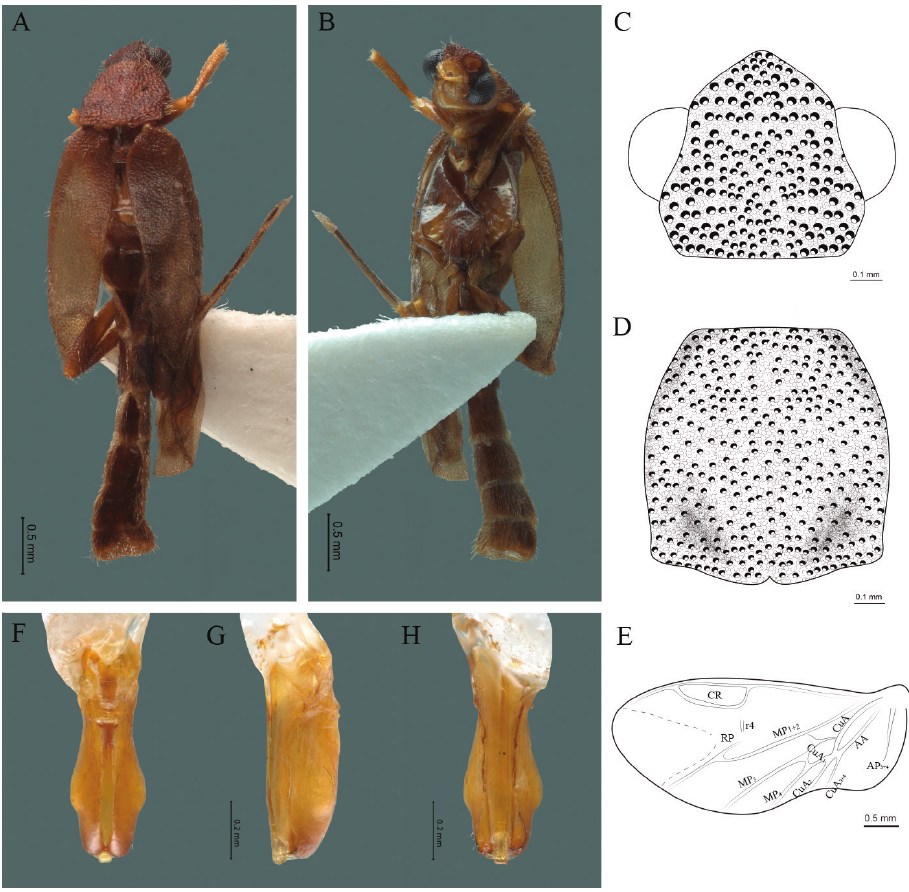
Figure 11. Cenophengus howdeni Zaragoza-Caballero, 1986, male. Habitus: A dorsal B ventral C head dorsal D pronotum dorsal E hind wing. Wing venation: CR = Radial Cell; r4 = radial 4 vein; RP = Posterior Radial vein; MP1+2 = Posterior Median vein; CuA = Cubital vein; AA and AP = Anterior and Posterior Anal veins. Aedeagus: F dorsal view G lateral view H ventral